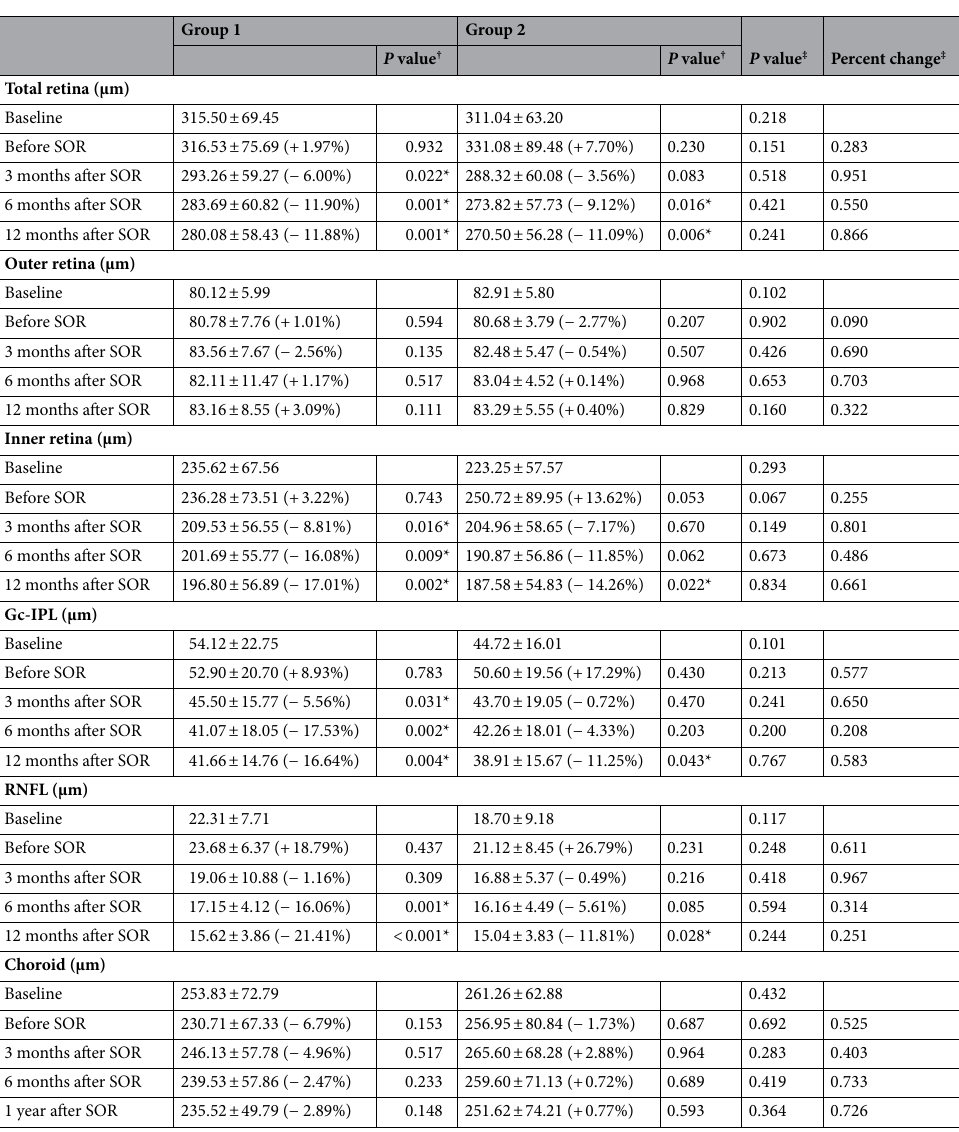
Table 3. Measurements of center macular retinal and choroidal thickness according to timing of ILM peeling. The values are presented as the mean ± standard deviation (percent change). Group 1, ILM peeling during SO injection surgery. Group 2, ILM peeling during SO removal surgery. † At each time point vs. baseline,